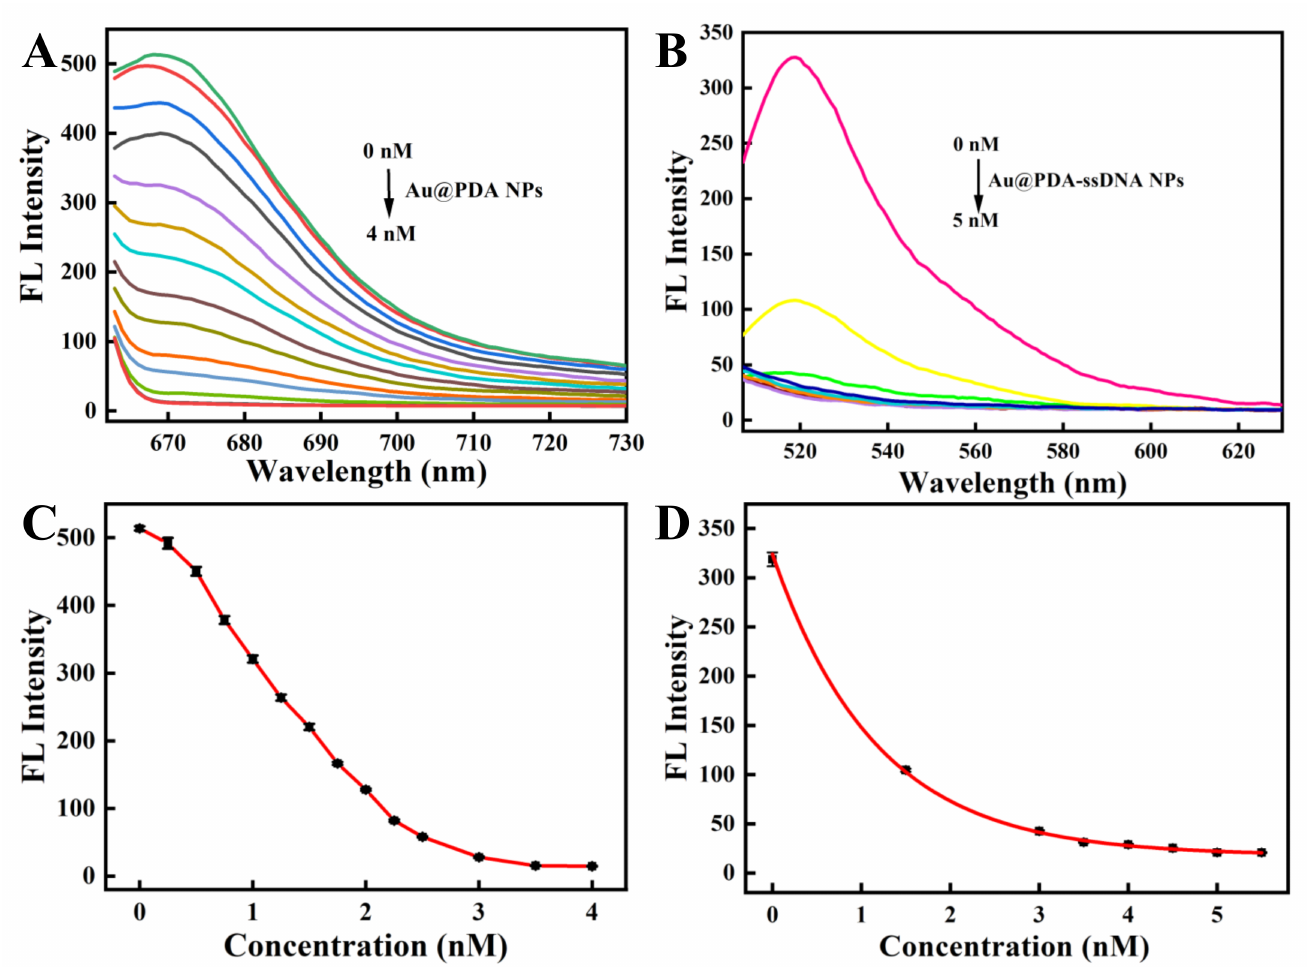
Figure 2. The fluorescence quenching spectra of the Cy5-labeled ssDNA (150 nM) with various concentrations of Au@PDA NPs ( A ) and the FITC-labeled oligopeptide (250 nM) with various con- centrations of Au@PDA–ssDNA NPs ( B ). Plot of the fluorescence intensity at various concentrations of Au@PDA NPs ( C ) and Au@PDA–ssDNA NPs ( D